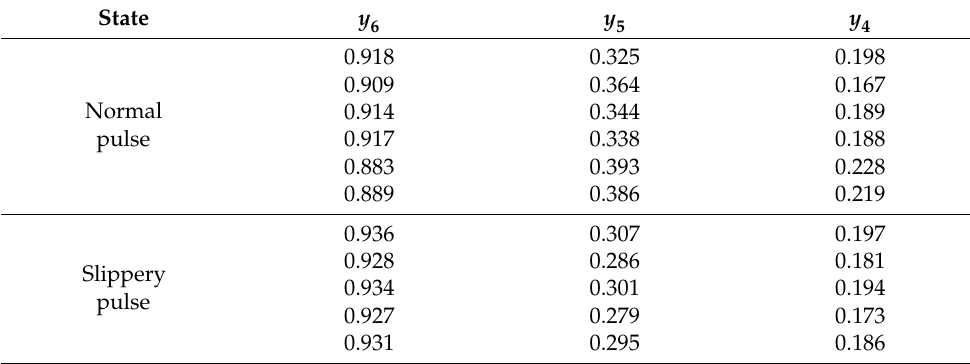
Table 2. The modal energy features.